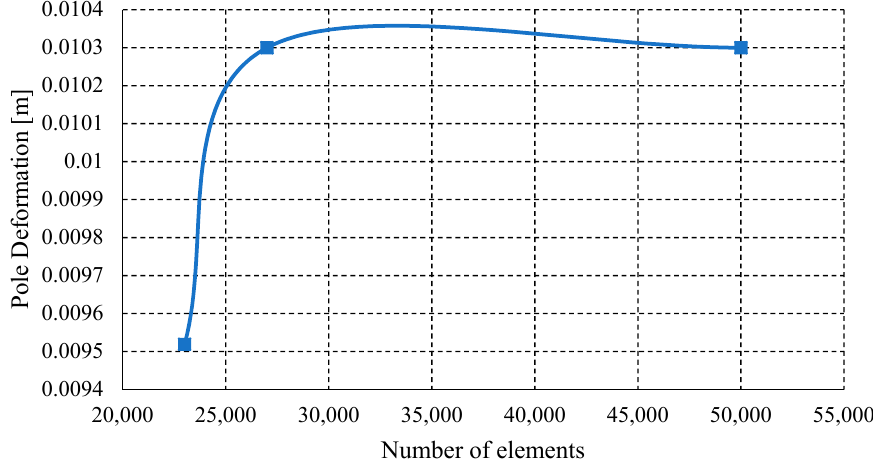
Figure 2. Sensitivity analysis of Reinforced TDM Pole Mesh tested using 23,500 elements, 27,000 elements and 50,000 elements.